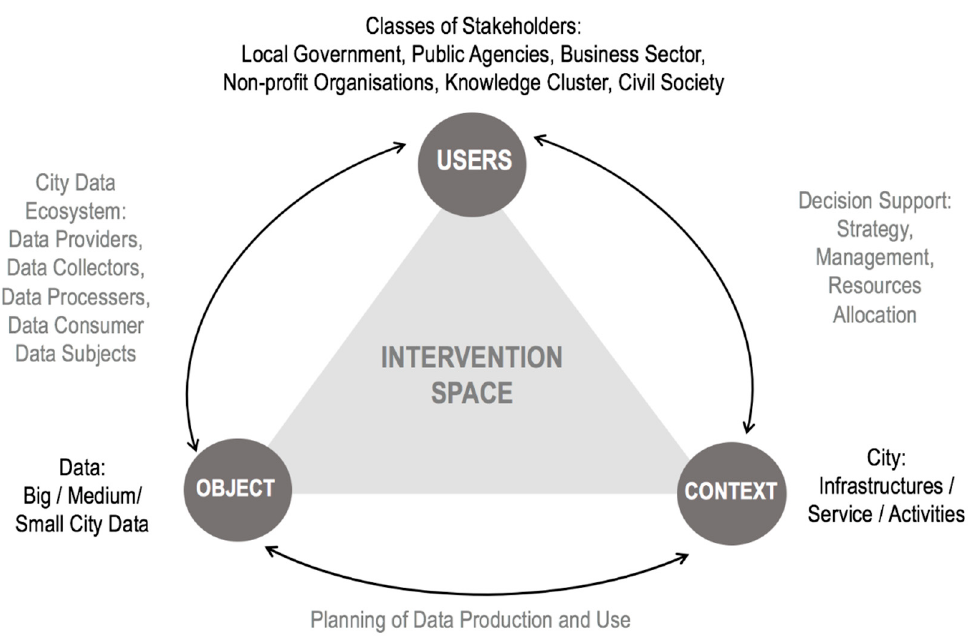
Figure 2. Framing of the problem of the city data governance for defining the intervention space for new solutions to the current issues related to the production and use of city data (source: author’s elaboration).